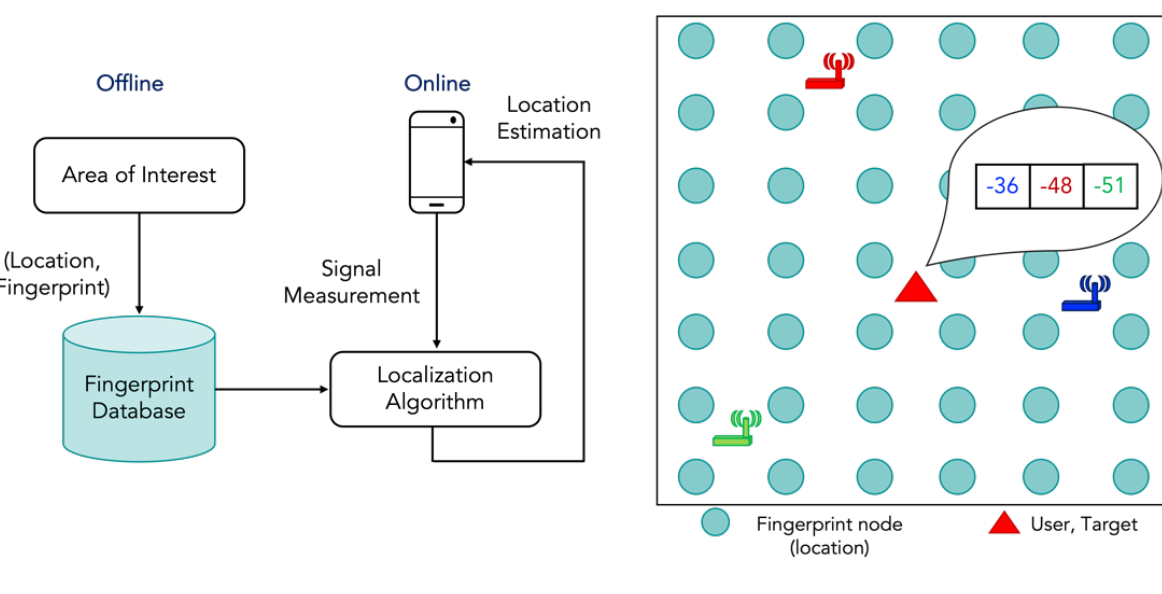
Figure 3. Fingerprint